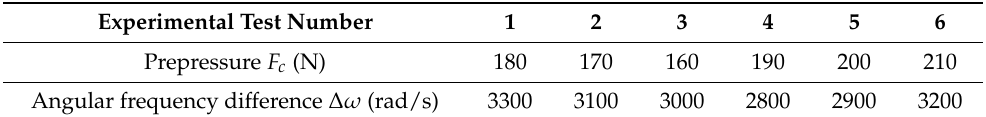
Table 5. Multicontrol variable set values table.